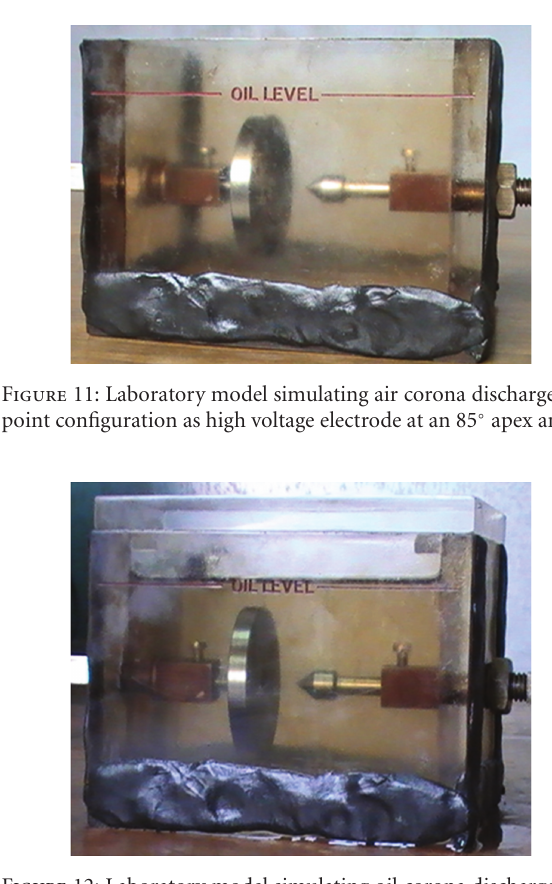
Figure 12: Laboratory model simulating oil corona discharge with point configuration as high voltage electrode at an 85 ◦ apex